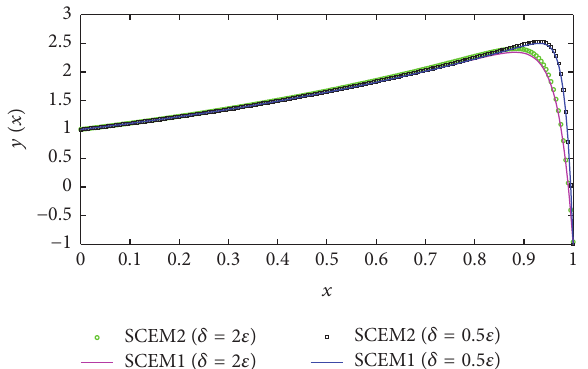
Figure 5: Delay effect on right layer problem for 𝜀 = 0.01 , 𝛿 = 0.5𝜀 , and 𝛿 = 2𝜀